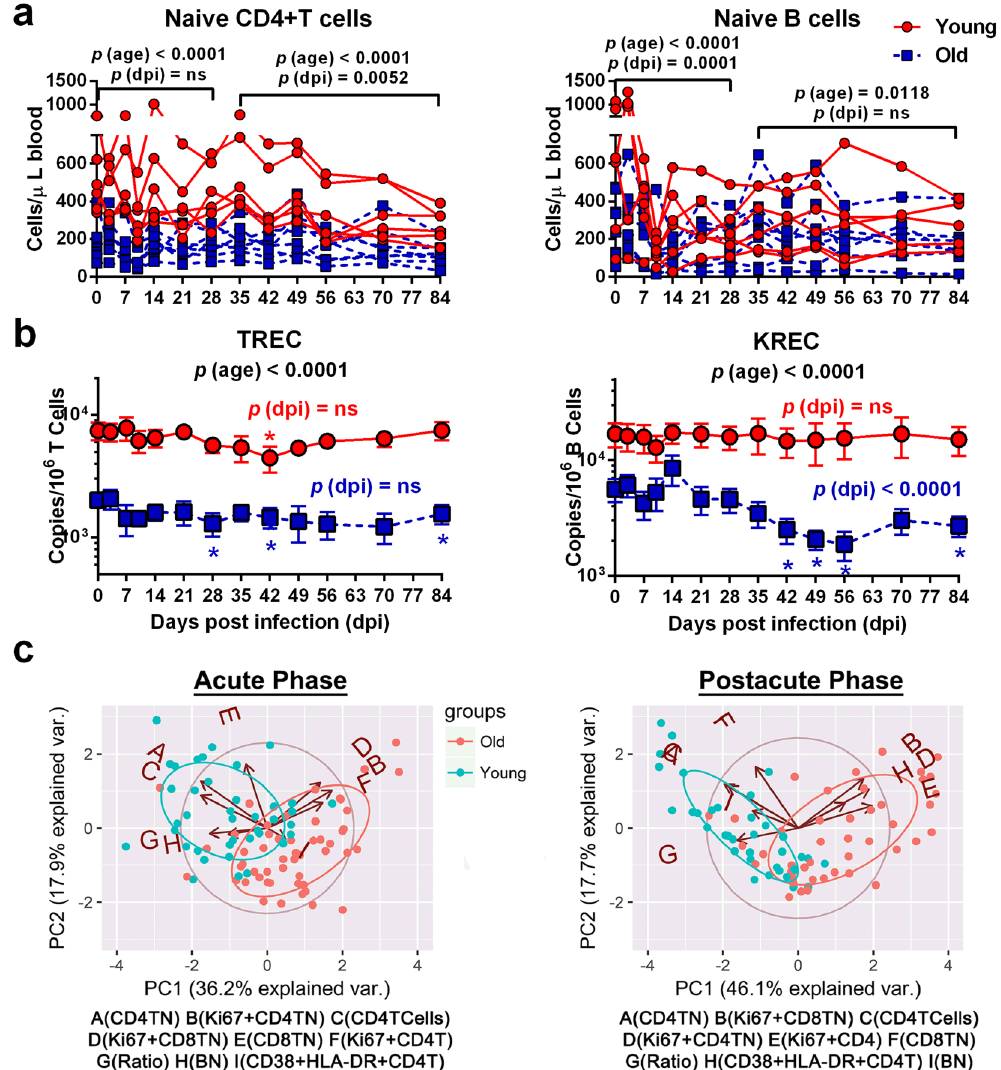
Figure 4. Old ChRM display a decreased number of naïve CD4 + T cells and B cells, as compared with young macaques. ( a ) The absolute number of naïve CD4 + T and B cells in the peripheral blood of young (n = 6, red circle) and old macaques (n = 8, blue square) is shown in scatter plots. ( b ) Comparison of the TREC (T cell receptor rearrangement excision circle) content in T cells or the KREC (kappa-deletion recombination excision circle) content in B cells from PBMCs in young and old macaques. The data are shown as the mean ± SEM. p (dpi) < 0.05 with color, statistically significant differences over the entire infection time, as determined by one-way ANOVA in the young (red) or old (blue) group. P (age) < 0.05, statistically significant differences between the young and old groups, as determined by two-way ANOVA. ( c ) Principal component analysis (PCA) of an immunophenotype data set in the acute and postacute phase was calculated by a varimax rotation method in package psych and graphed by package ggbiplot2 with R. Each dot represents a sample from a time point that is plotted against its expression levels for 9 variables that differed over time and between age groups, as determined by two-way ANOVA. The variables are shown in capital letters and are arranged alphabetically according to their communalities from high to low. CD4TCells, CD4 + T cell number; CD4TN, naïve CD4 + T cell number; CD8TN, naïve CD8 + T cell number; Ratio, CD4/CD8; BN, naïve B cell number; Ki67 + CD4TN, % of Ki67 + CD4 + naïve T cells; Ki67 + CD8TN, % of Ki67 + CD8 + naïve T cells; Ki67 + CD4T, % of Ki67 + CD4 + T cells; CD38 + HLA-DR + CD4T, % of CD38 + HLA-DR + CD4 + T